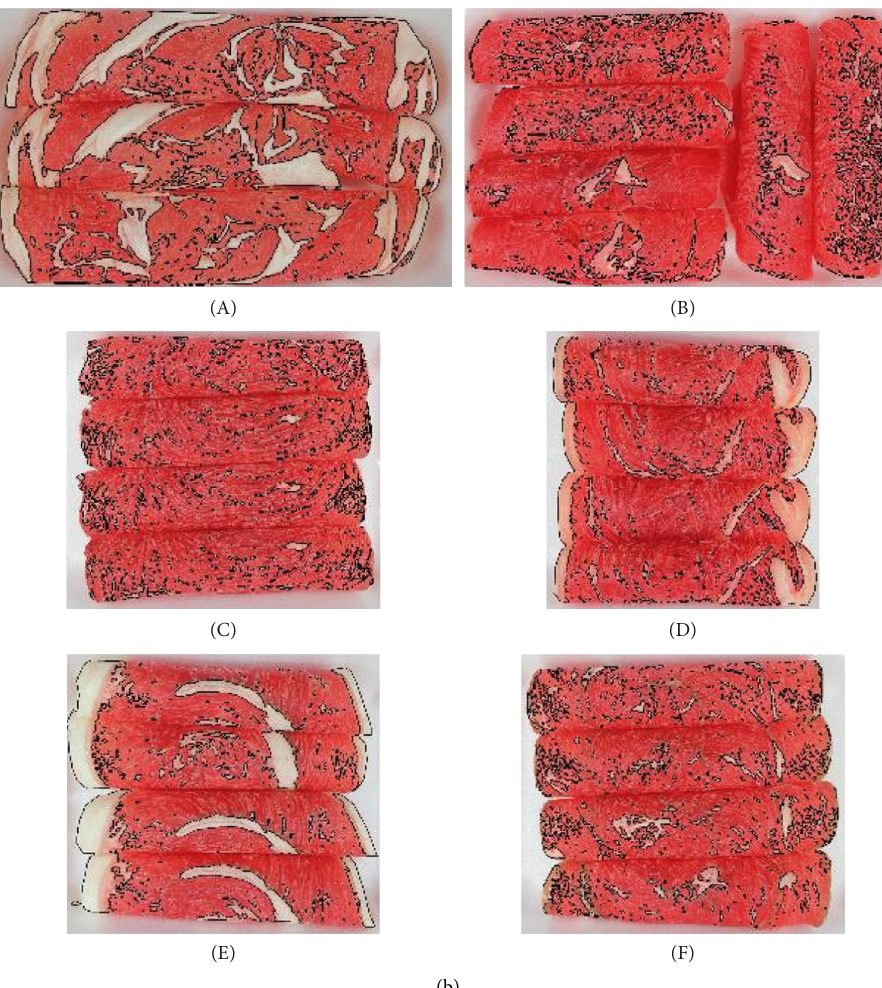
Figure 3: (a) Images showing the processing steps for determining the percentage of visible fat within the samples: (A) cropped, (B) mask, (C) masked, (D) grayscale, (E) contrast adjusted, (F) B&W, (G) imopen and imclose, (H) identify perimeter, and (I) fat%: 34.57. (b) Images of the samples used in the survey and their percentages of visible fat: (A) 34.57, (B) 13.54, (C) 10.75, (D) 23.77, (E) 27.57, and (F)